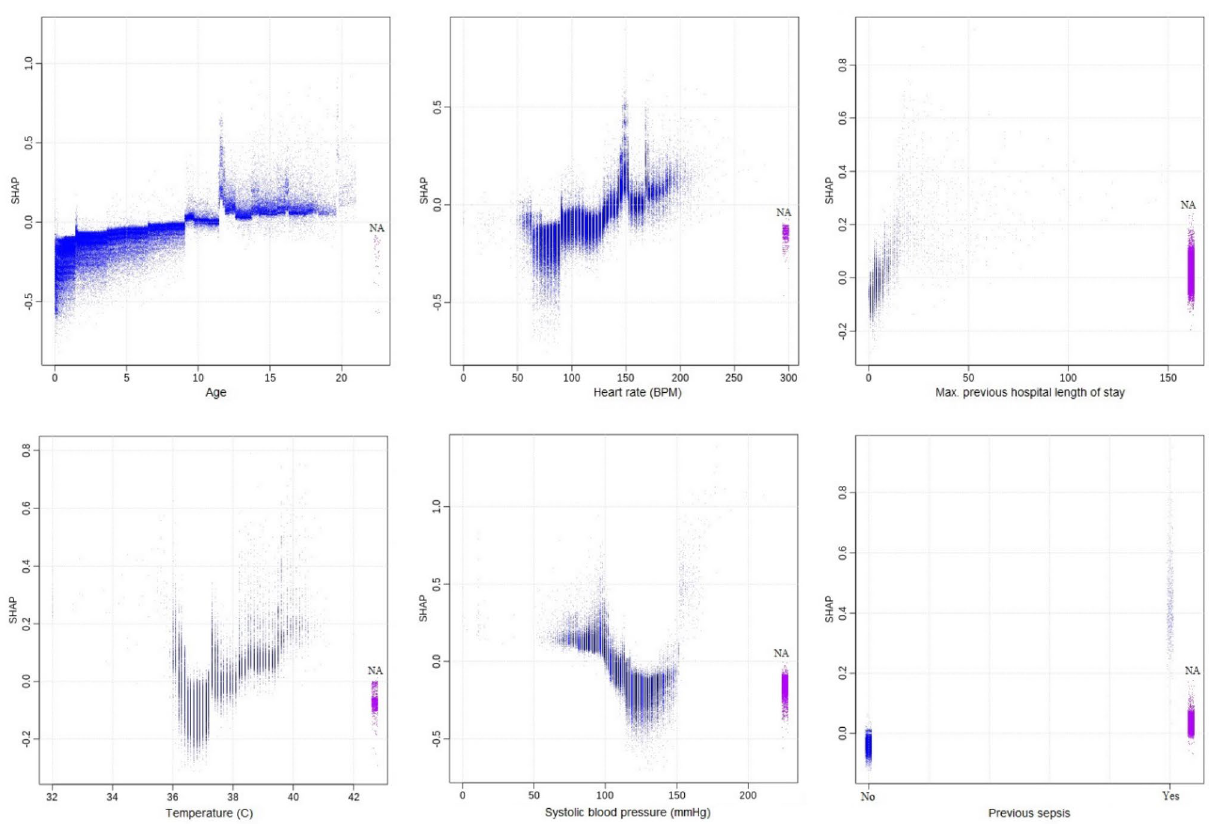
Figure 2. Shapley additive explanation for severe sepsis: top 6 most important